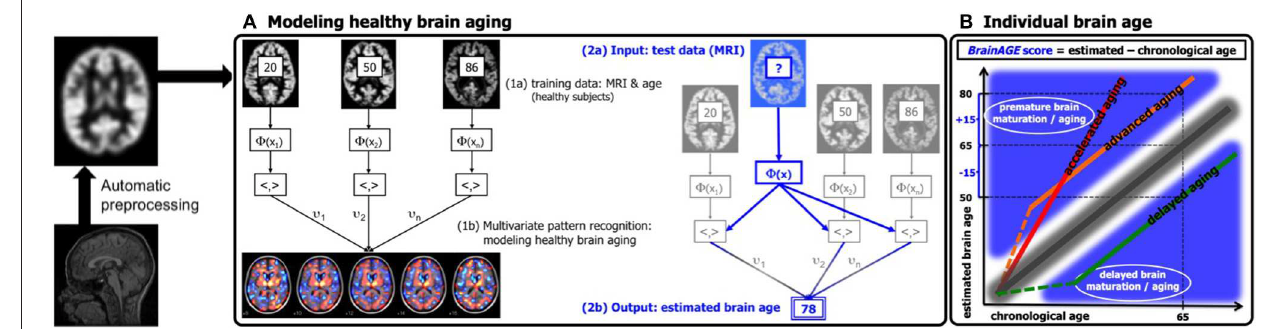
FIGURE 1 | Depiction of the BrainAGE concept. All MRI data are automatically preprocessed via VBM. (A) The model of healthy brain aging is trained with the chronological age and preprocessed structural MRI data of a training sample (left; with an illustration of the most important voxel locations that were used by the age regression model). Subsequently, the individual brain ages of previously unseen test subjects are estimated, based on their MRI data. (B) The difference between the estimated and chronological age results in the BrainAGE score, with positive BrainAGE scores indicating advanced brain aging (orange line), increasing BrainAGE scores indicating accelerating brain aging (red line), and negative BrainAGE scores indicating delayed brain aging (green line). [Figure and legend adapted from Franke et al. (45), with permission from Hogrefe Publishing,